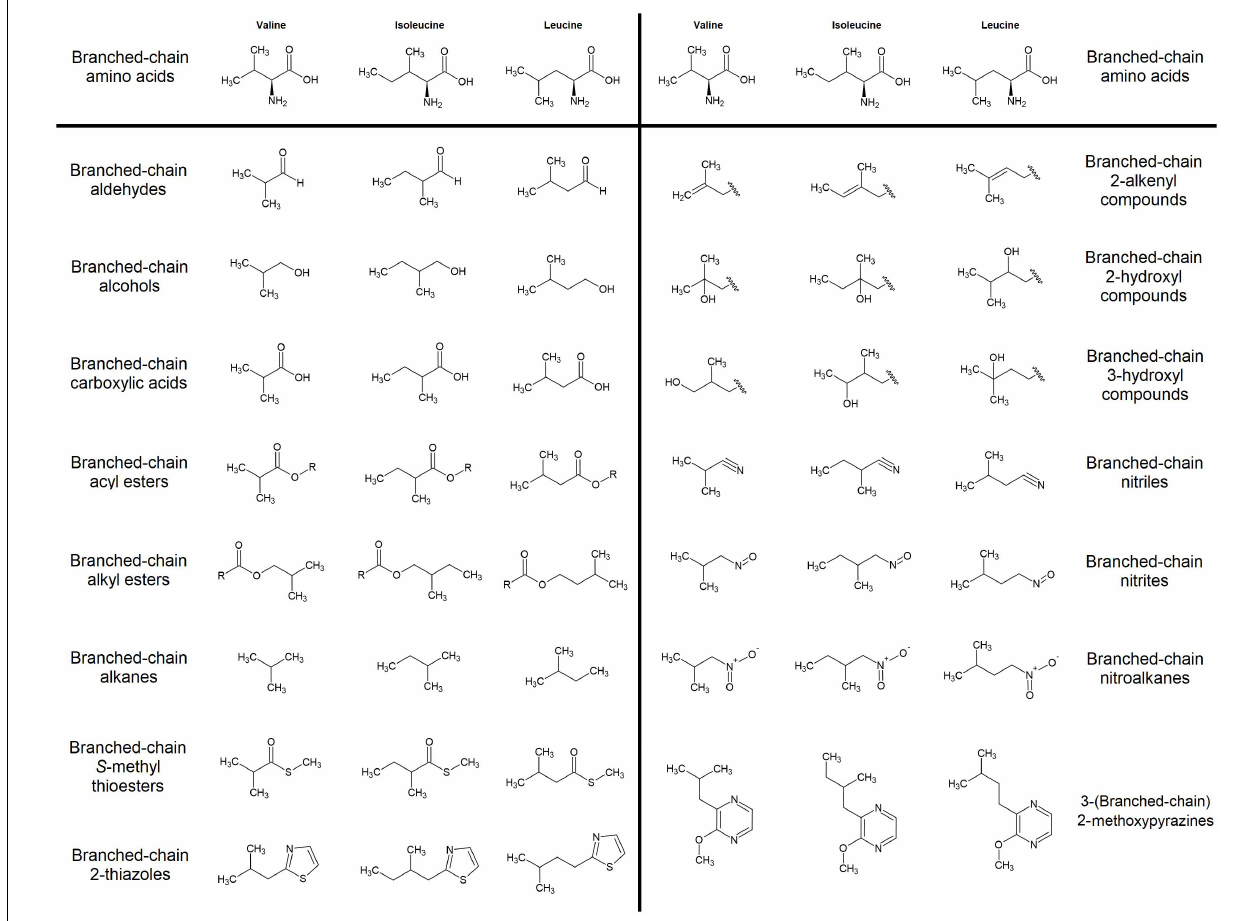
FIGURE 1 | Categories of branched-chain volatile compounds detected in edible fruits. At least one volatile from each family was reported in at least one of the 175 fruit volatile studies examined in this review (see Supplementary Table 1 ).